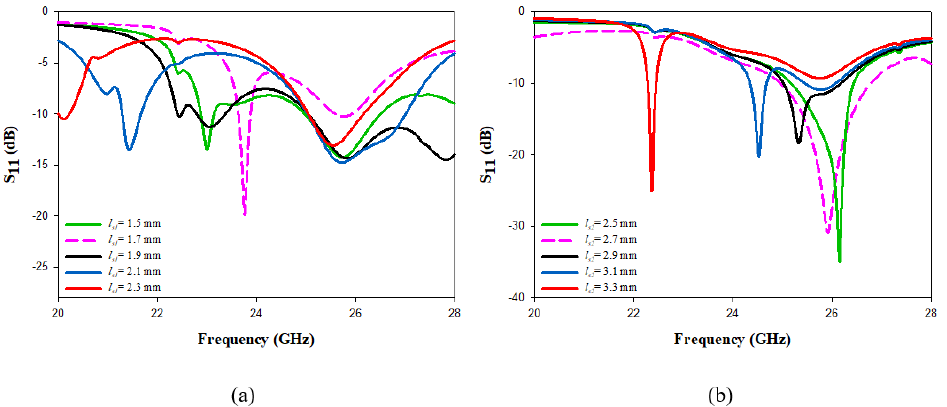
Figure 3. The effects of changing the cross-slot arm’s length on the reflection coefficient ( a ) l s 1 ( b ) l s 2 .